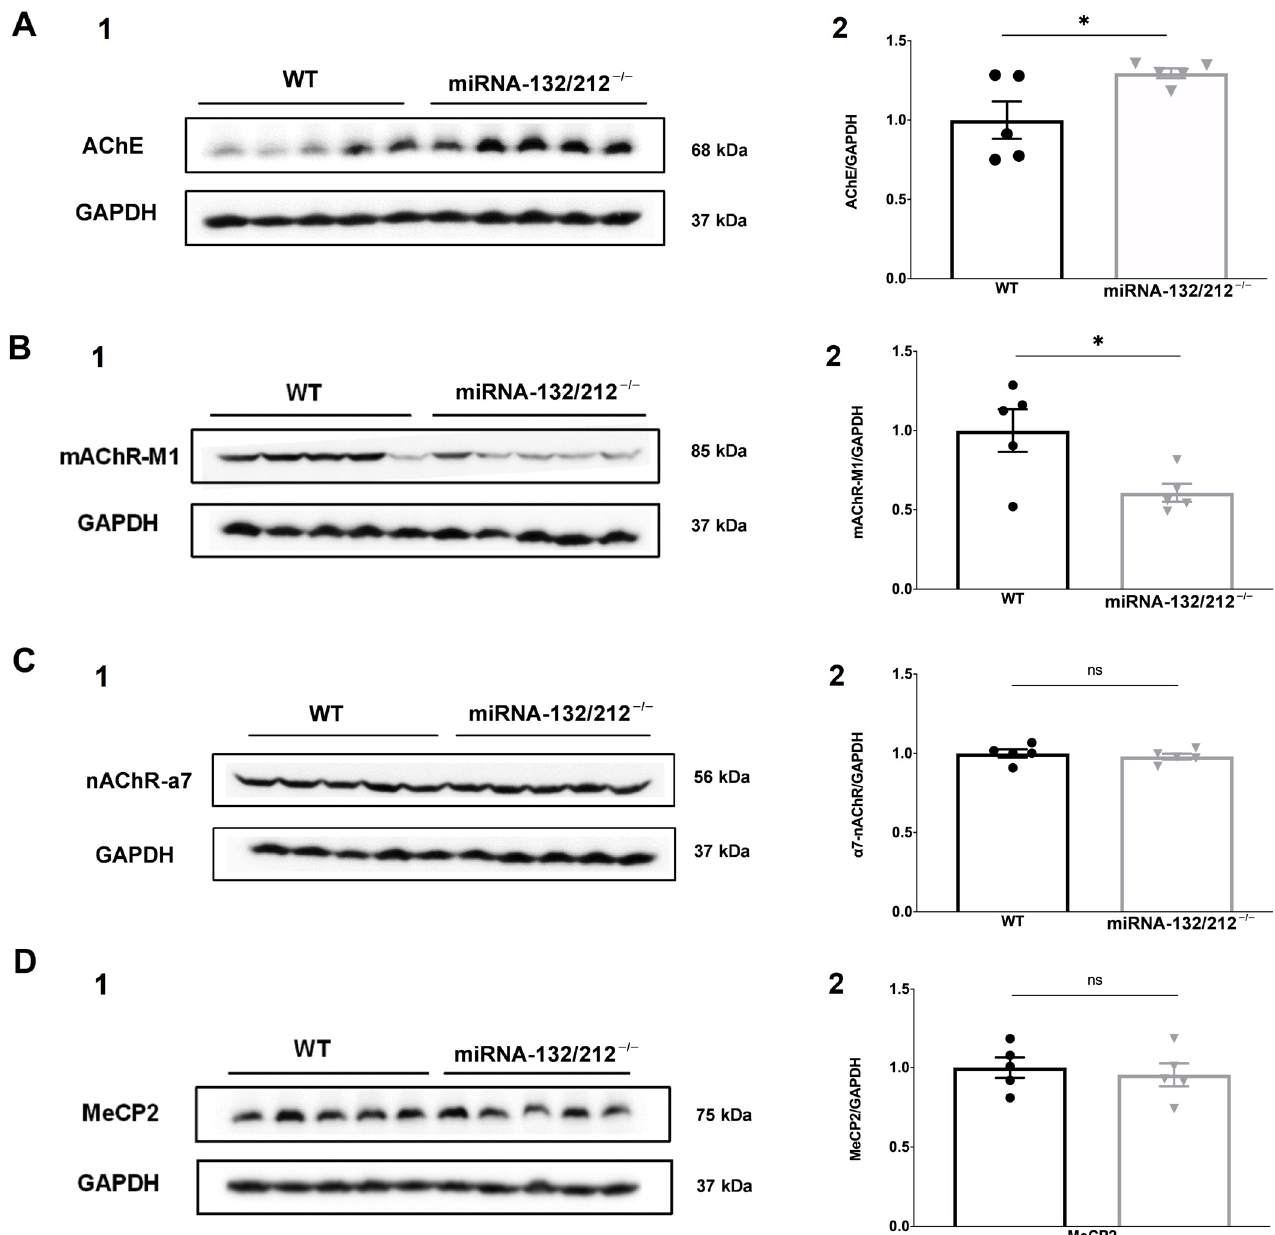
Figure 6. miRNA-132/212 deletion altered AChE and mAChR-M1 protein expression. Protein expression levels of AChE, mAChR-M1, nAChR- α 7 and MeCP2 were determined by Western blot analysis from total cell lysates of female mouse bilateral hippocampi. The left columns ( A – D and numbered with 1 in each case) depict representative immunoblots for the proteins of interest and GAPDH loading controls. The right columns ( A – D and numbered with 2 in each case) depicts aligned scatter plots representing the protein levels of the respective proteins of interest, normalized to their respective GAPDH loading control protein levels, for lysates from miRNA 132/212 − / − and WT control mice. ( A ) Lysates from miRNA 132/212 − / − mice exhibited significantly higher AChE expression levels, as compared to their respective WT controls. ( B ) In contrast, lysates obtained from miRNA 132/212 − / − mice showed significantly lower mAChR-M1 expression levels, as compared to WT controls. However, samples from miRNA 132/212 − / − and WT control mice did not differ significantly regarding ( C ) nAChR- α 7 and ( D ) MeCP2 protein expression. Data is expressed as mean ± SEM. n = 5 per group. AChE: Acetylcholinesterase, nAChR- α 7: alpha-7 nicotinic receptor, mAChR-M1: muscarinic acetylcholine receptor M1, MeCP2: methyl-CpG binding protein 2. p < 0.05 was considered significant, * p < 0.05, ns: no statistical significance.